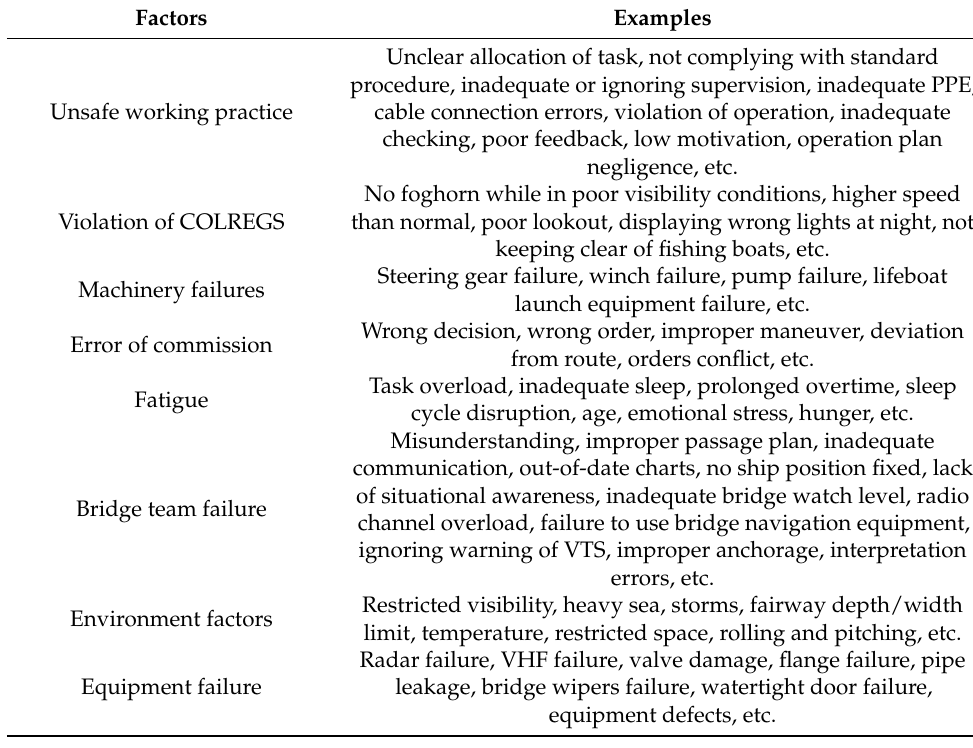
Table 12. The details of the eight contributing